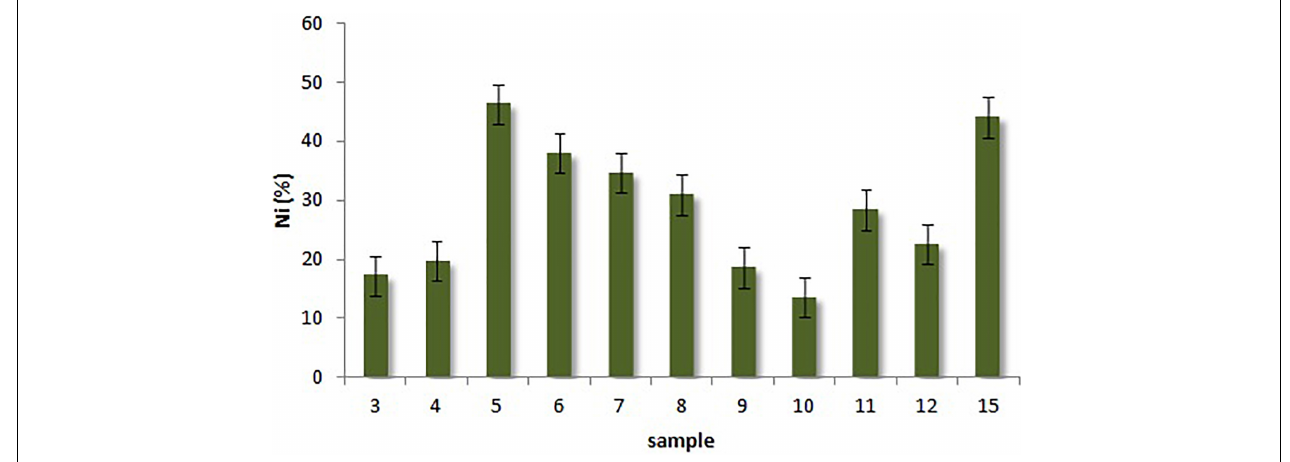
FIGURE 4 | Decrease of the nickel content in the ash from the sludge incinerator by the microbial consortium.